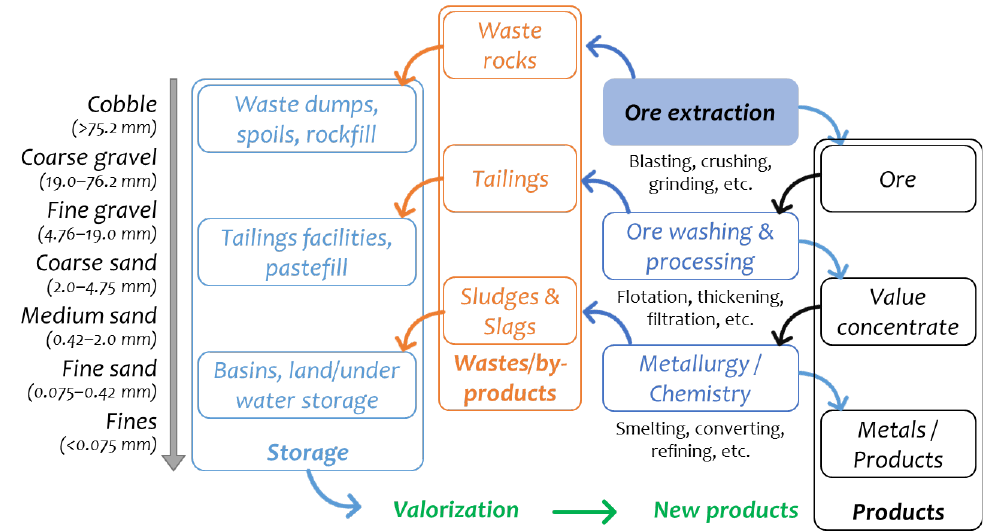
Figure 1. Mining cycle from ore extraction to metal/mineral beneficiation, developed from [5,6].